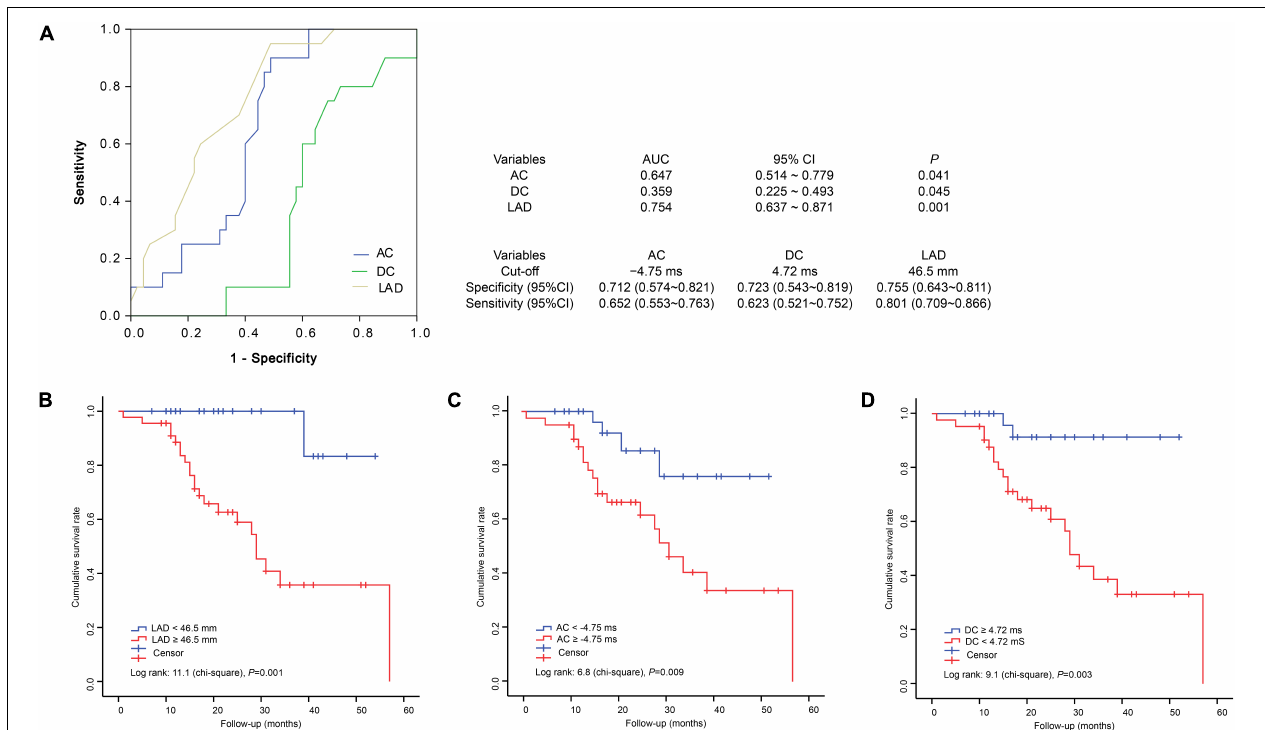
FIGURE 3 | Receiver operating characteristic curves and Kaplan–Meier analysis of 60-month survival rates by LAD, AC, and DC status. ROC, receiver operating characteristic; AUC, areas under the ROC curves; 95%CI, 95% confidence interval. (A) ROC, AUC and cut-offs. (B) Cumulative survival rates of patients grouped by LAD status. (C) Cumulative survival rates of patients grouped by AC status. (D) Cumulative survival rates of patients grouped by DC